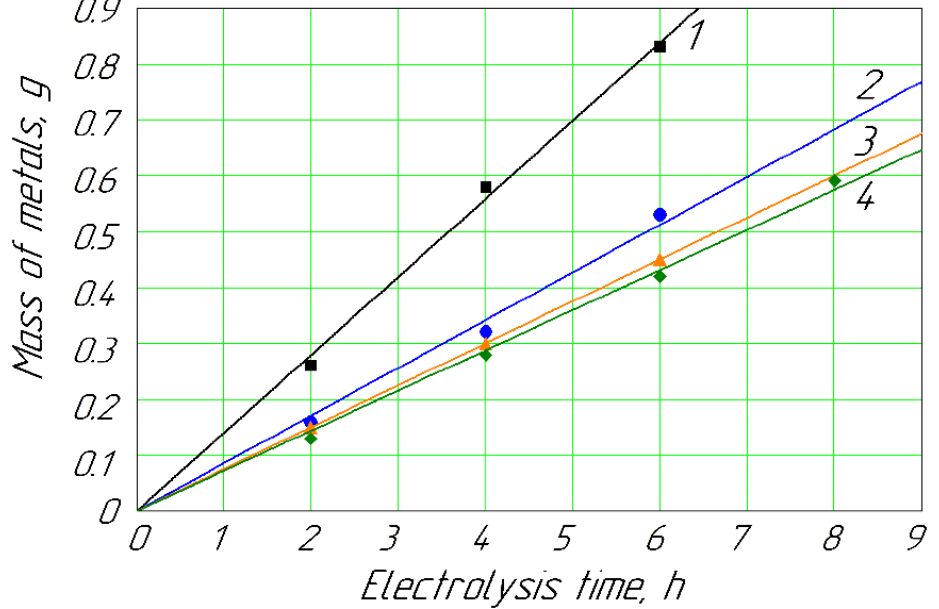
Figure 4. Deposition of metals on the cathode vs. hydrodynamic mode for concentration of Cd 2+ and Zn 2+ ions of 0.026 mol/L: 1, Cd ( Re = 2975); 2, Cd ( Re = 392, without mixing); 3, Zn ( Re = 2975); 4, Zn ( Re = 392, without mixing).